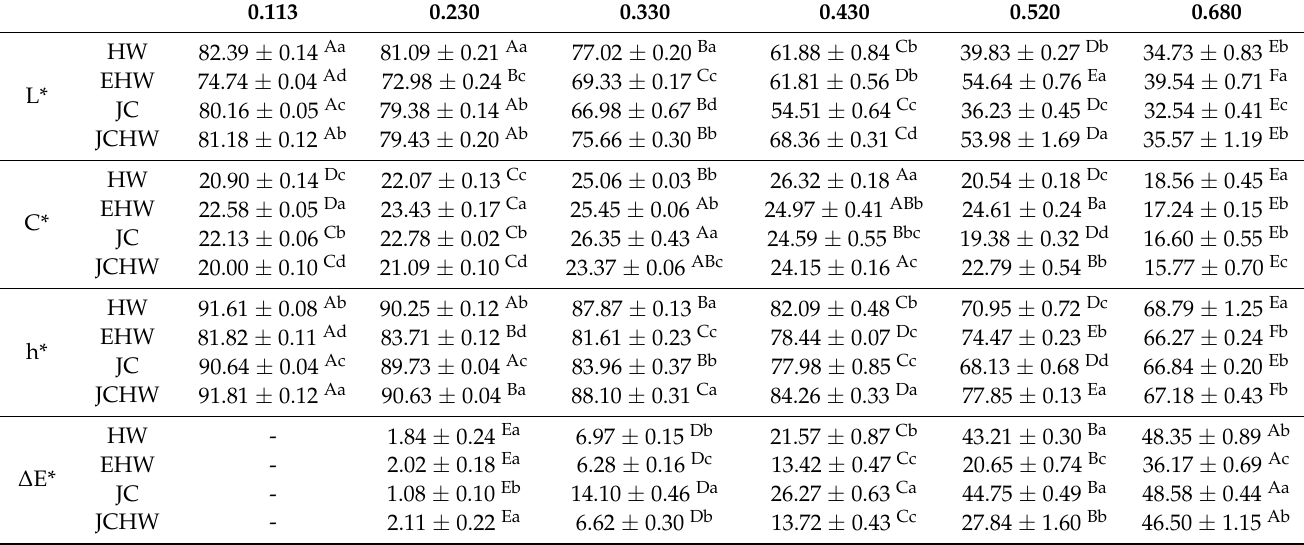
Table 3. Colour attributes and colour differences ( ∆ E* was calculated as the difference with the colour at a w = 0.113). HW: hot water; EHW: extrusion + hot water; JC: jet cooker; JCHW: jet cooker + hot